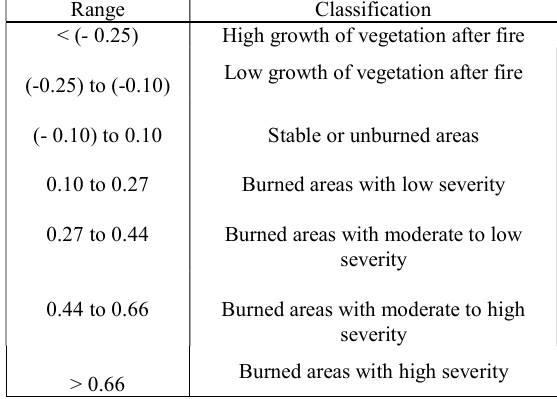
Table 8. NBR Index